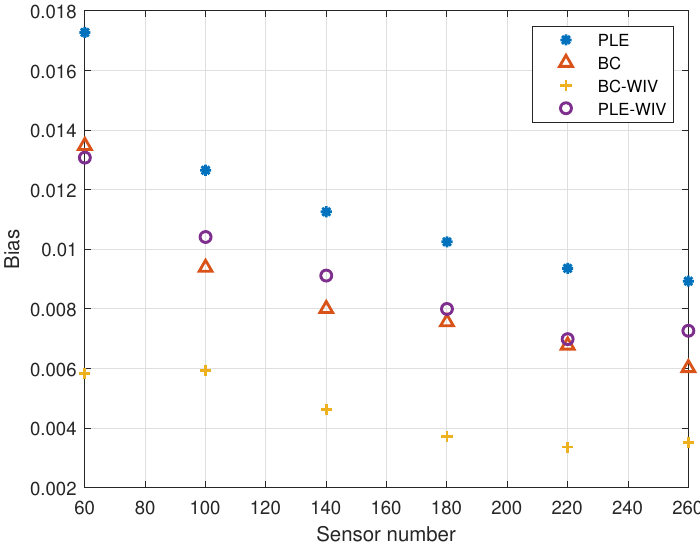
Figure 8. Bias norm with increasing sensor number at the difference of 40 for each